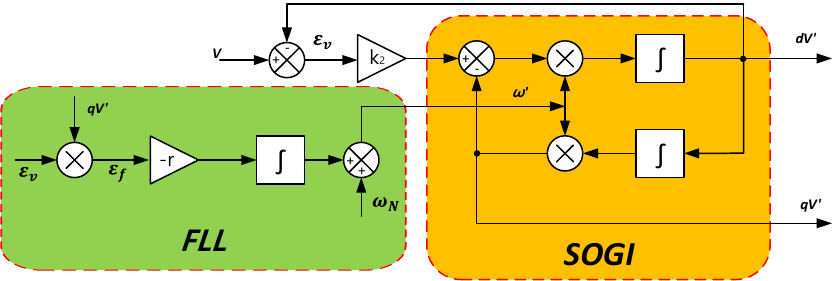
Figure 10. Block diagram of second-order generalized integrator-frequency locked loop (SOGI-FLL).